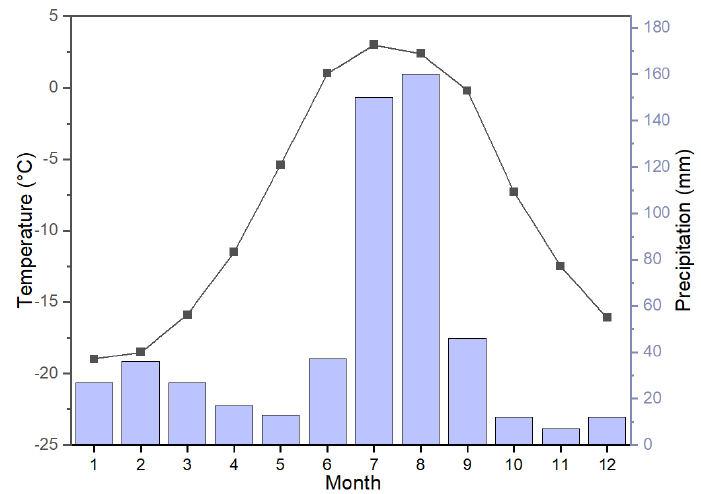
Figure 2. Modern temperature and precipitation levels of the study area. Data from (https://www.klima.tu-berlin.de/ (accessed on 10 October 2021)) [28]. Black dots: temperature; Light purple: precipitation.